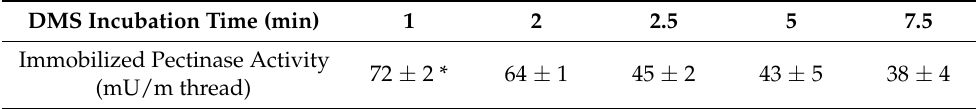
Table 2. The effect of incubation time in DMS on the activity of immobilized pectinase. DMS Incubation Time (min) 1 2 2.5 5 7.5 Immobilized Pectinase Activity 72 ± 2 * 64 ± 1 45 ± 2 43 ± 5 38 ± 4 (mU/m thread)